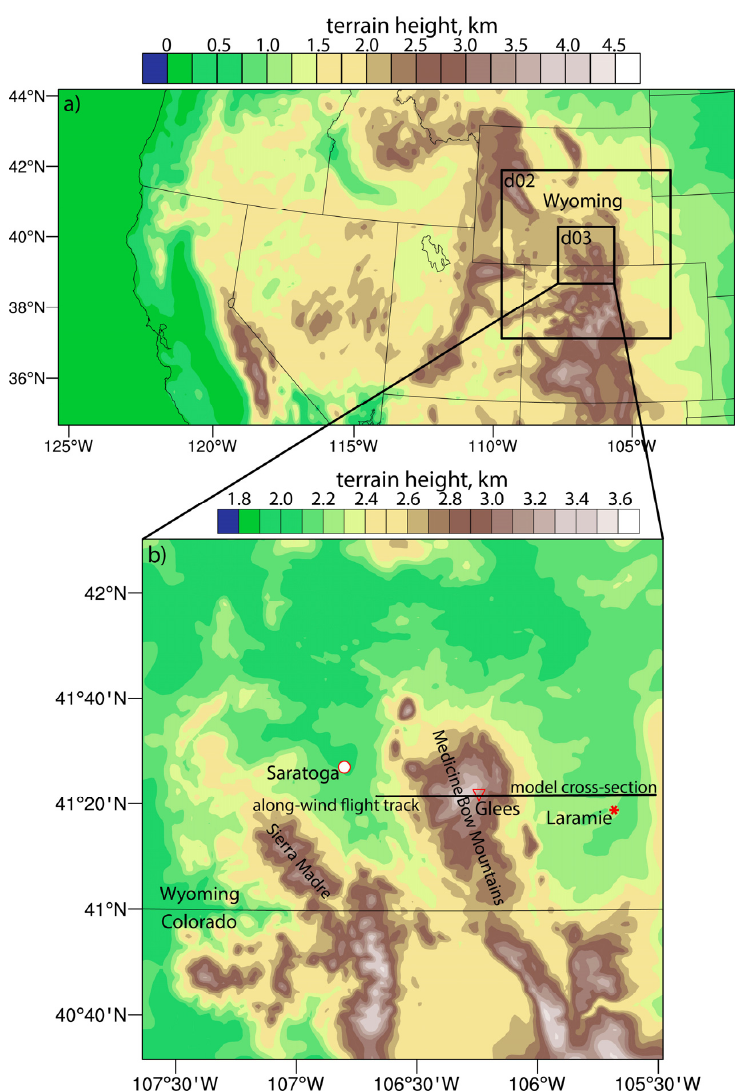
Figure 1. Terrain maps showing ( a ) the three WRF model domains (with coastline and state boundaries within the USA, and ( b ) the inner domain showing the model cross section and surface sites. The four UWKA flight tracks were along the model cross-section, but were shorter, ranging from 30 to 60 km in length.